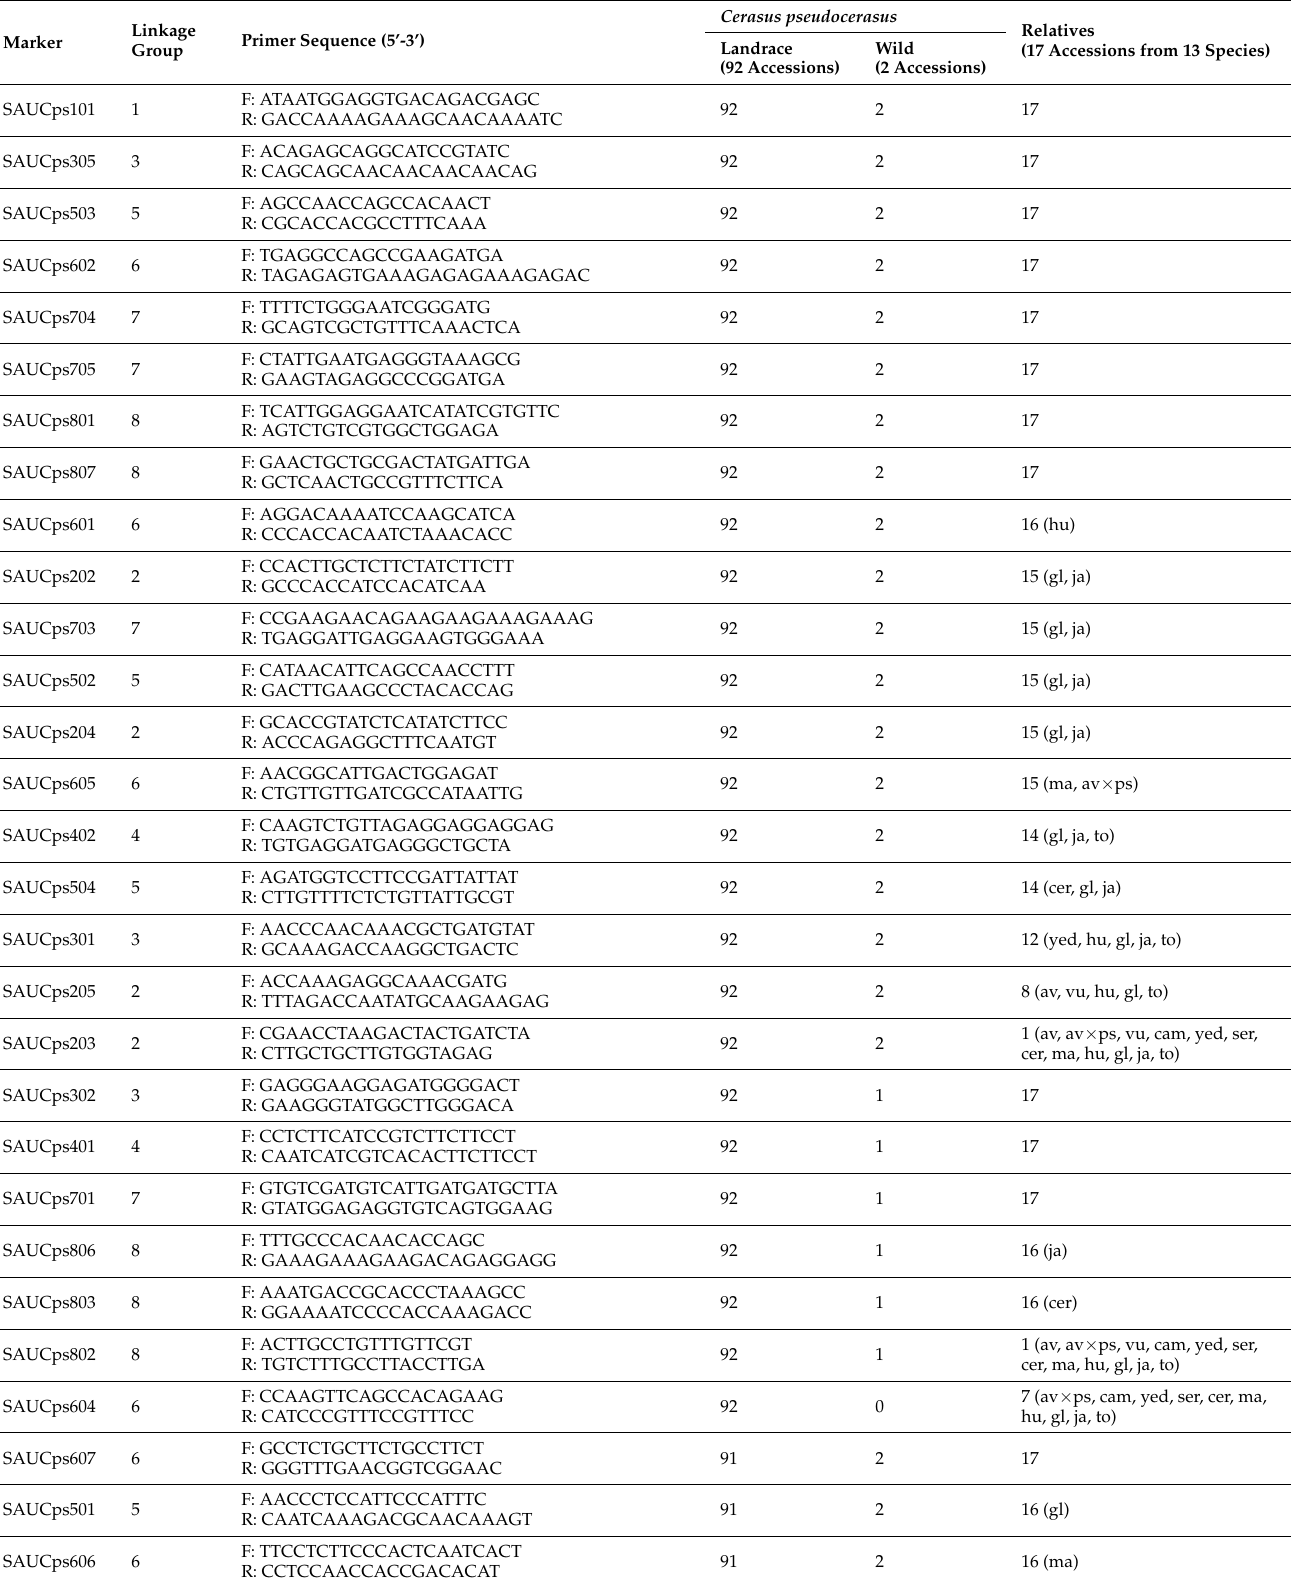
Table 1. Thirty-nine developed SSR markers and their transferability across Cerasus pseudocerasus and